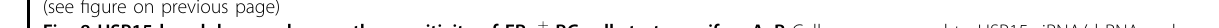
Fig. 8 USP15 knockdown enhances the sensitivity of ER α + BC cells to tamoxifen. A , B Cells were exposed to USP15 siRNA/shRNA and tamoxifen (TAMO, 20 μ M/L). Cell viability was detected by adding MTS. C Colony formation assay was done. D , E EdU staining assay was done and images were captured by fl uorescence microscope. * p < 0.05, ** p < 0.01, *** p < 0.001 versus each vehicle control. F T47D cells were treated with tamoxifen, USP15 siRNA or the combination of the two drugs. Cell apoptosis was tested by fl ow cytometry for apoptotic cells. G The pooled data has been showed. ** p < 0.01 versus each vehicle control. H And protein was collected for western blot to evaluate Bcl-2 expression. I The treated cells were subjected to FACS for cell distributions. J The percent of cell number on each phase was showed. K Proteins were extracted from T47D treated with USP15 siRNA and tamoxifen, subjected to western blot for Cyclin D1, Rb, p-Rb, p27 expression. L A proposed mechanism for USP15 to regulate the ER α level in breast